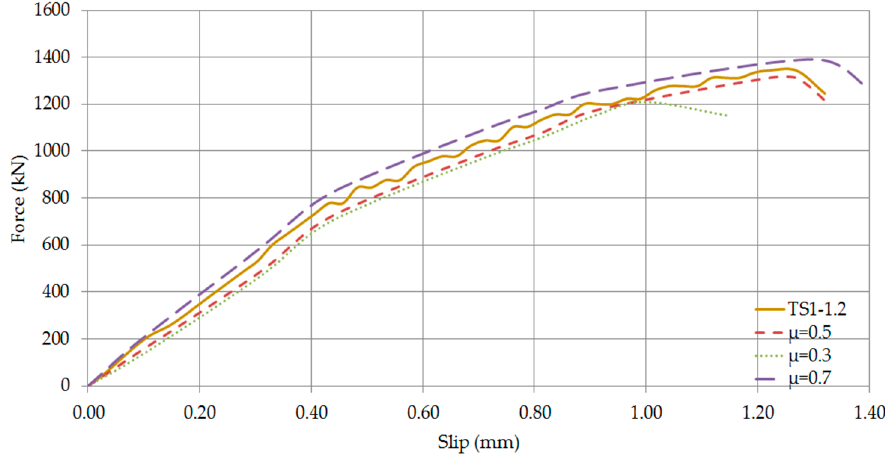
Figure 25. Axial force—Slip Curves of TS1-1.2 (Comparison of friction coefficients).